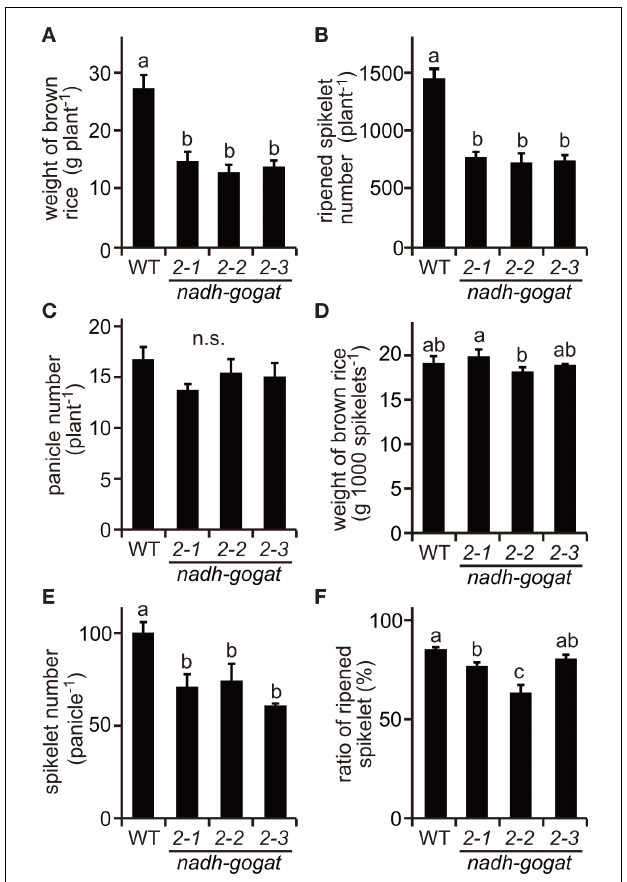
FIGURE 4 | Productivity of OsNADH-GOGAT 2 knockout mutants cultivated in paddy field in 2008. (A) Total weight of brown rice per plant. Names of three mutant lines were the same as described in Figure 2 . (B) Total ripened spikelet number per plant. (C) Total panicle number per plant. (D) 1,000 brown rice weight. (E) Spikelet number per panicle. (F) Proportion of well ripened grains. Means of three independent samples and SD are indicated. Significant differences in these three lines by one-way ANOVA are indicated by lower-case letters (a, ab, b, and c). No significant difference is indicated as in n.s. Different letters indicate significant differences ( P < 0.05) in Holm–Sidak corrected post hoc tests following an ANOVA.